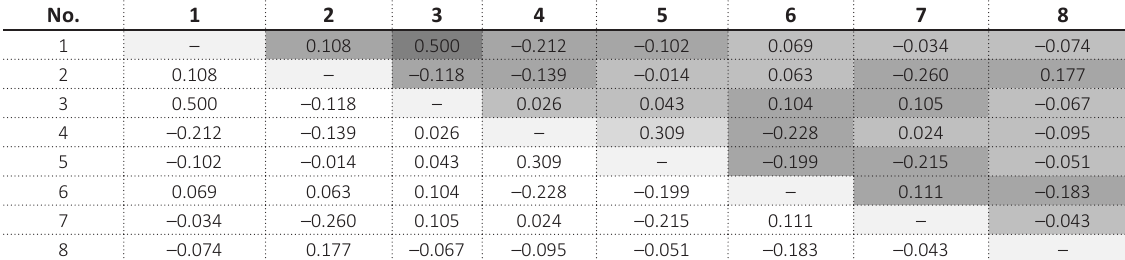
Table 2. Correlation dependence between the estimated indicators of scientific efficiency and the place of stay